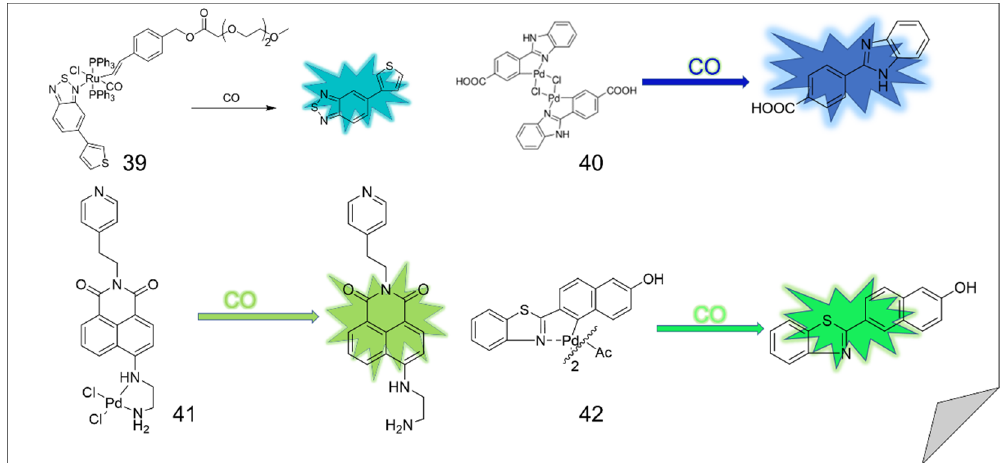
Figure 15. ( A ). The structure of probe 38 and its principle of detecting CO. ( B ) Co-localization experiments on cell membranes. Copyright (2018) Royal Society of Chemistry [48].